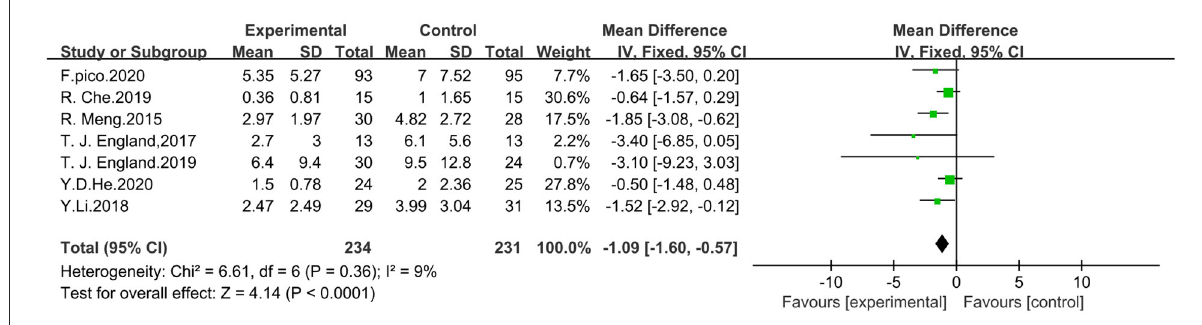
FIGURE4 Forest plot showing effect of RIPostC on NIHSS scores.